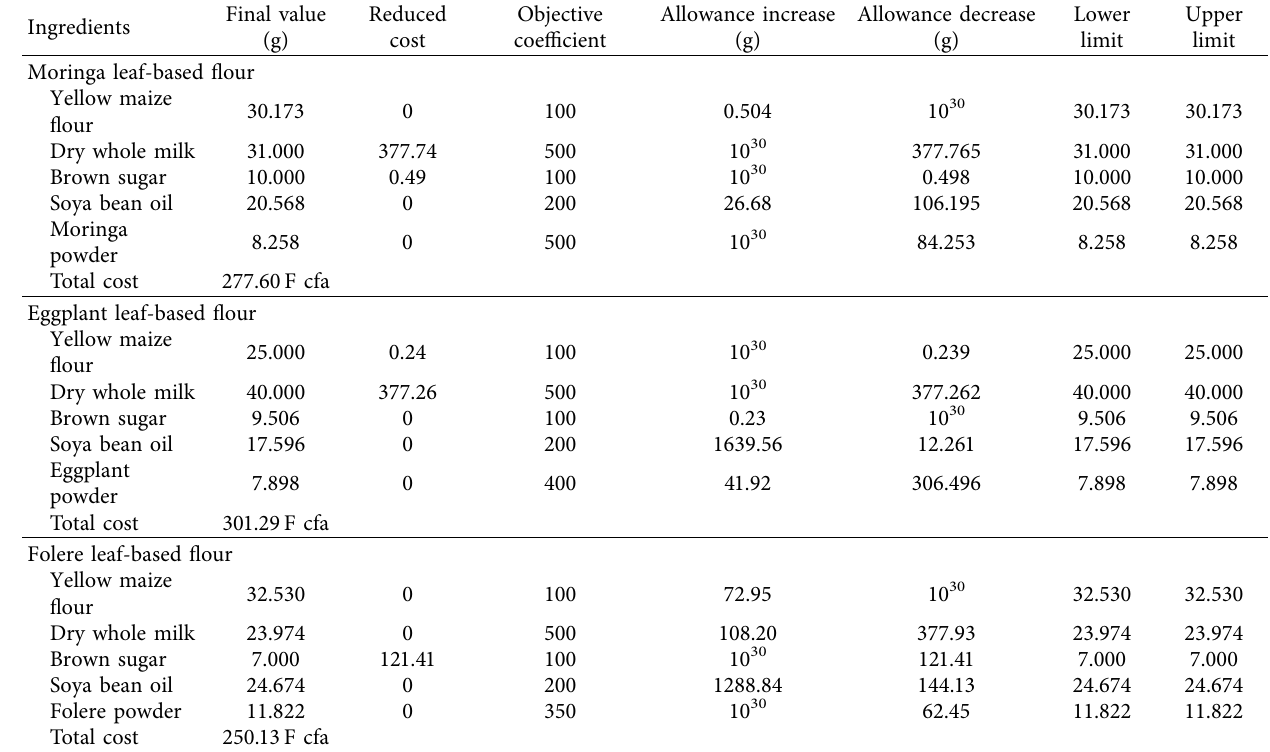
Table 2: Results of LP optimization and sensitivity analysis of the three formulated flours.